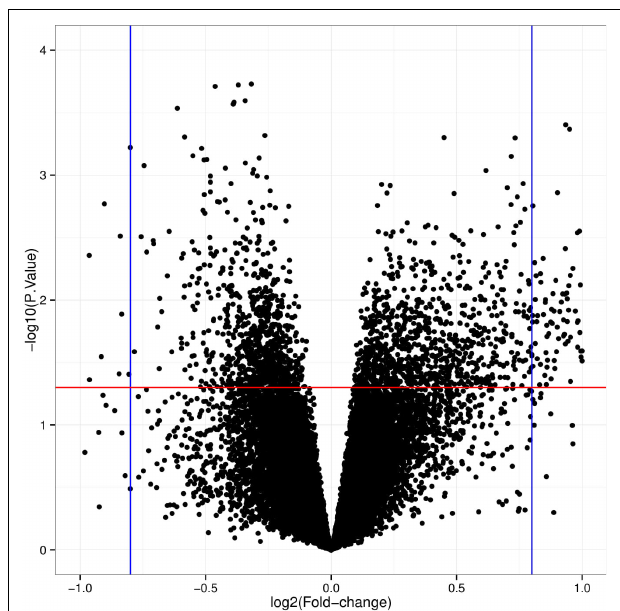
TABLE 2 | Significantly upregulated and downregulated DEGs between two groups from GSE30153 dataset are tabulated.